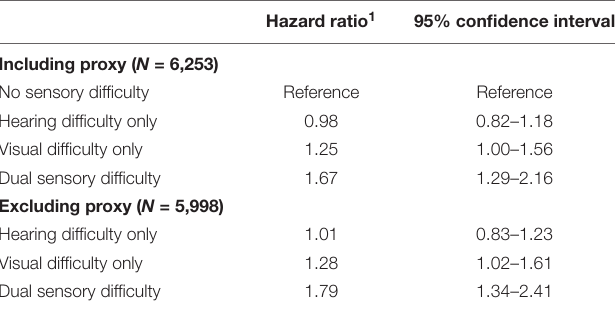
TABLE 2 | Hazard of incident clinically significant depressive symptoms by self-reported sensory difficulty status.